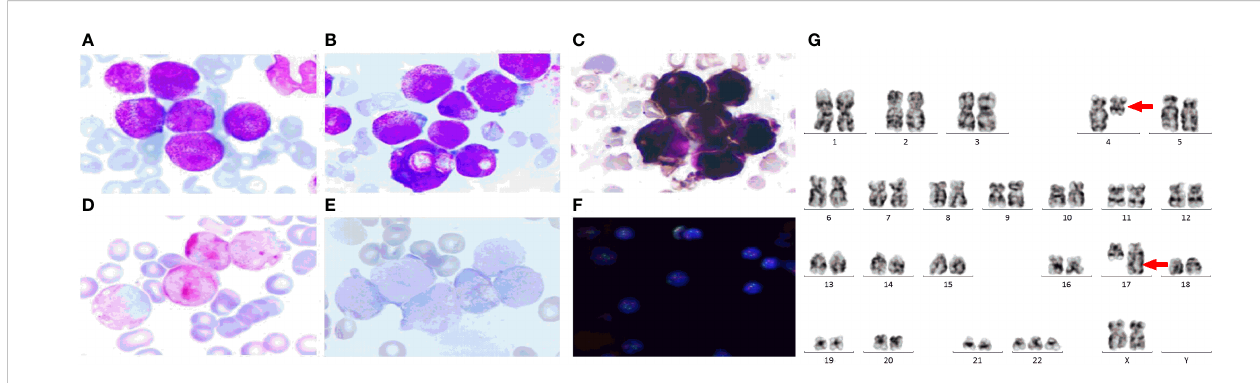
FIGURE 1 The clinical information of the APL patient. (A) Peripheral blood cell morphology at initial diagnosis. ×400; (B) Bone marrow morphology at initial diagnosis. ×400; (C) Peroxidase staining.×400; (D) Naphythol AS-D chloroacetate esterase staining.×400; (E) a -naphthol acetate esterace staining.×400; (F) FISH using the PML::RARA dual-color, dual fusion translocation probe. (G) The chromosome karyotype of the APL patient, the red arrows indicate the chromosome translocation. The PML probes are labeled with orange fl uorescein and RARA probes with green fl uorescein, the green and orange signal form a yellow fusion signal when PML::RARA fusion gene is present.